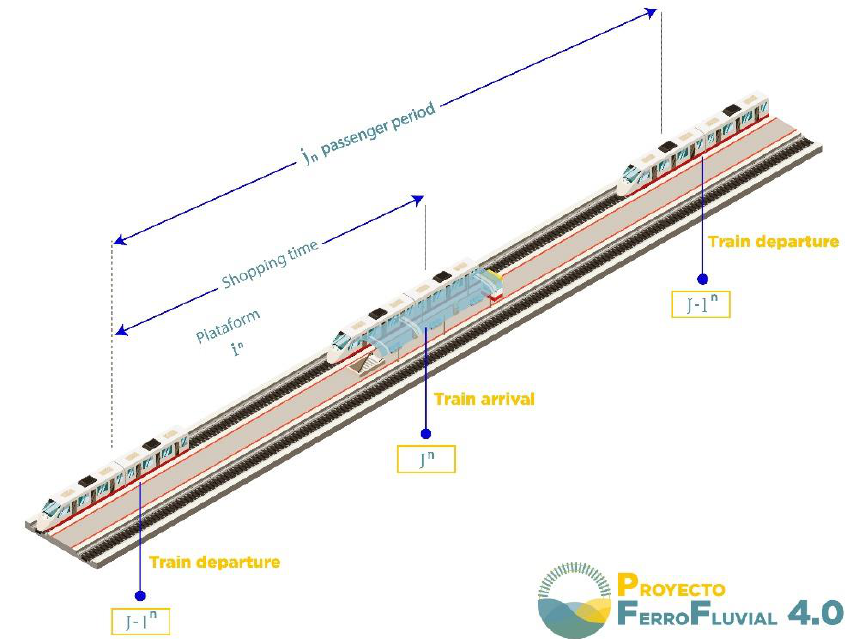
Figure 7. Diagram of an ideal train platform for passenger flow modified from [65].